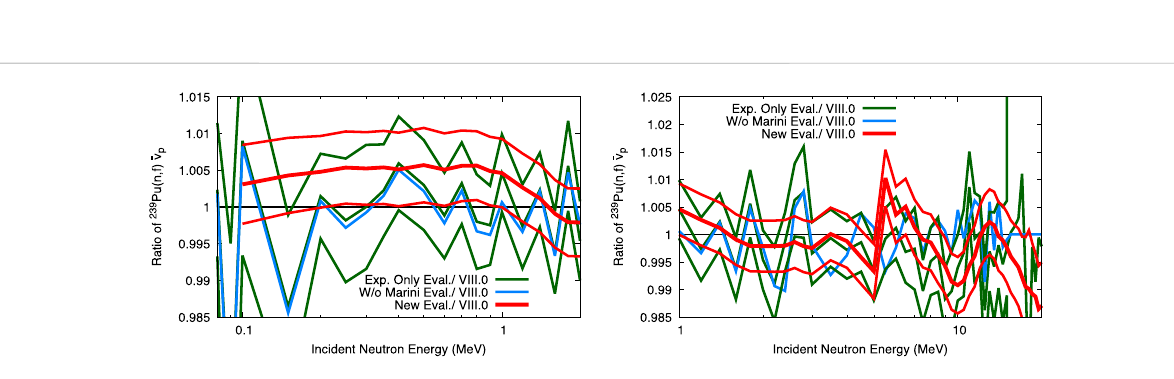
in the bottom of Figure 7. However, most of the previous data were measured with fi ssion chambers, while NIFFTE TPC shape data were obtained with a time-projection chamber which allows accurate tracking of charged particles in three dimensions.